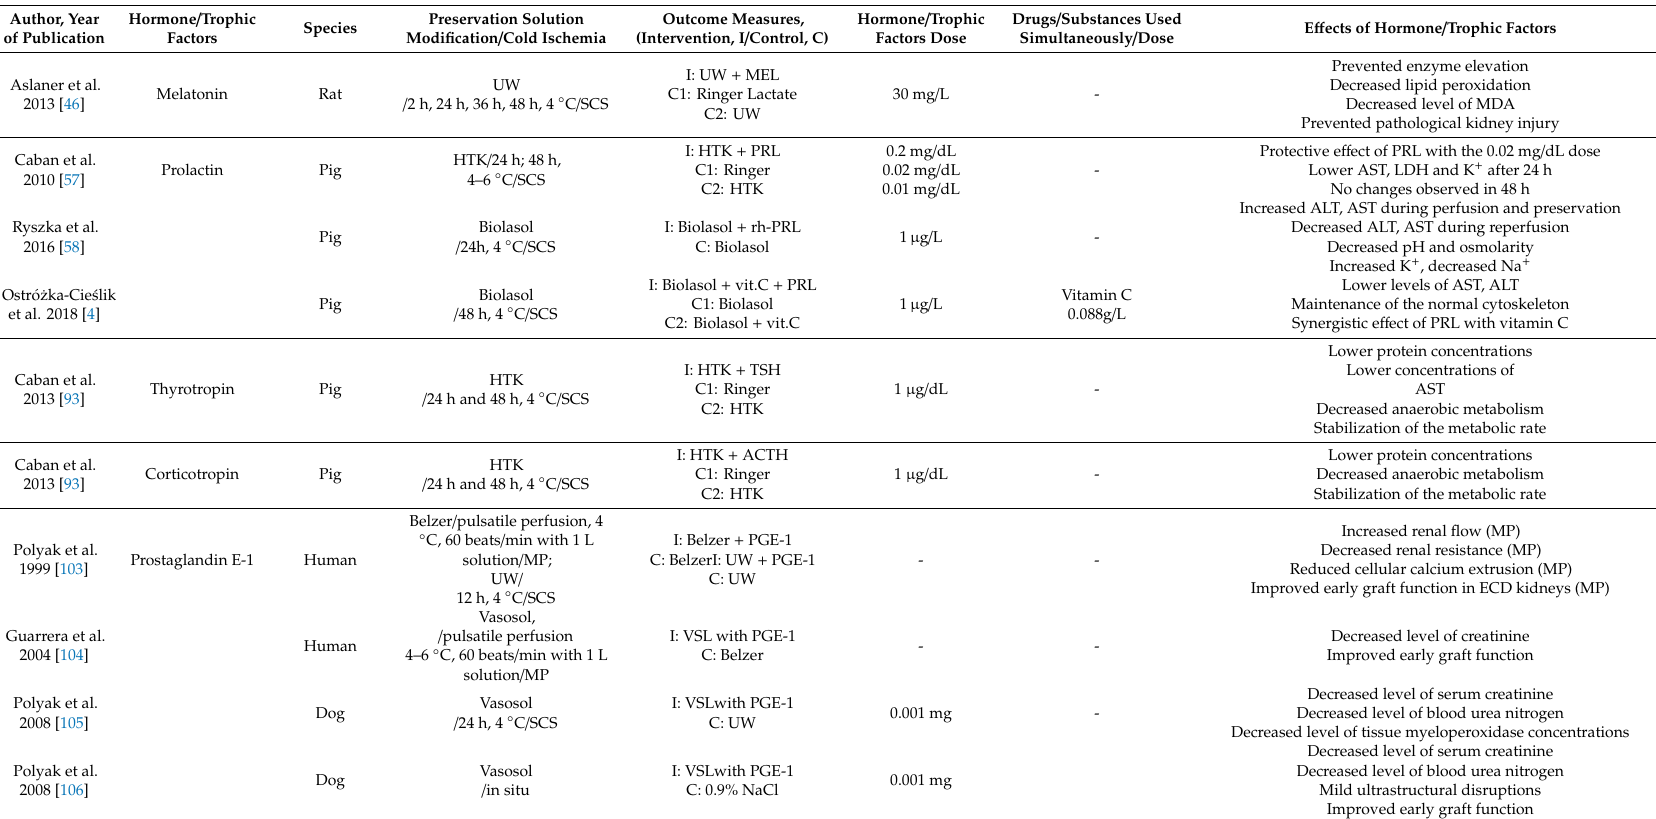
Table 3. Strategies based on modifications of preservation